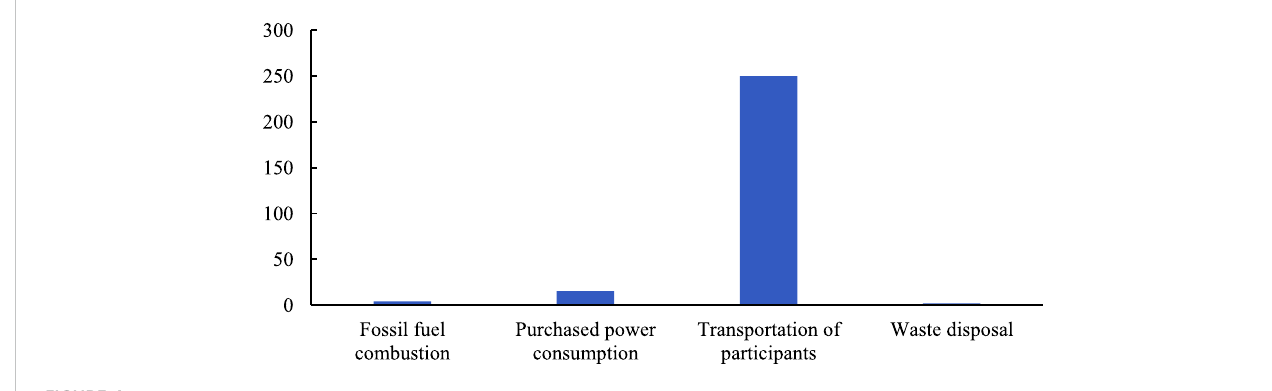
FIGURE 4 Carbon dioxide emissions from different departments of a medium-sized artwork auction (unit: ton).